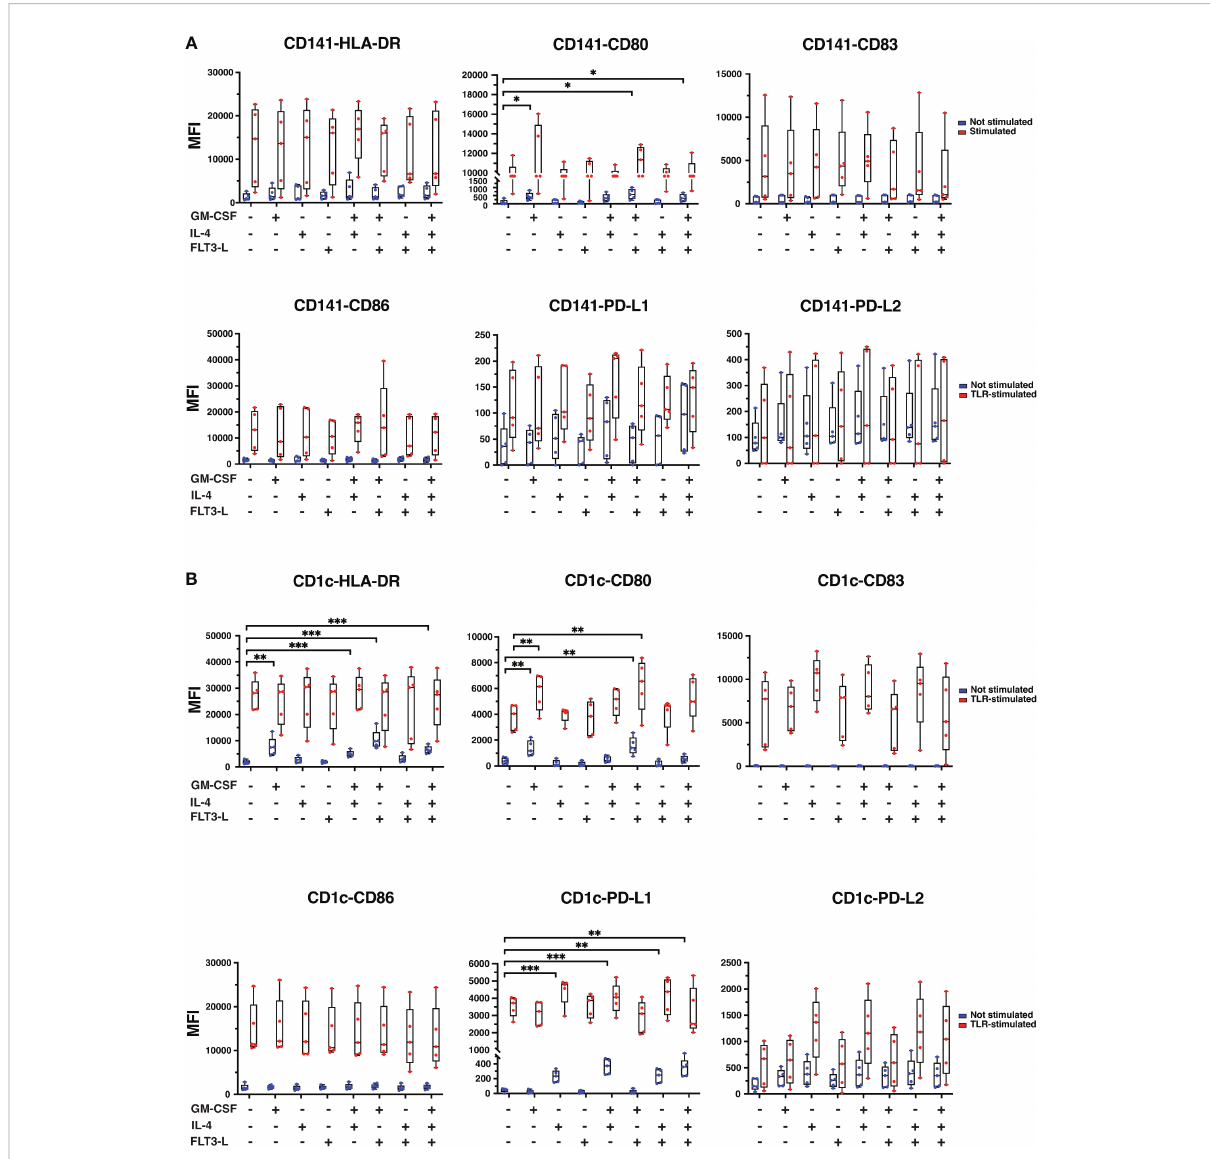
FIGURE 3 The expression of CD surface markers in CD141+ and CD1c+ cells upon different cytokine treatments in the presence or absence of TLR-stimuli for 24hrs. (A) CD141+ and (B) CD1c+ cells were cultured in media containing cytokines as indicated in the graphs. CD141+ cDC was treated with Poly I:C (12.5 µg/ml LMW and 12.5 µg/ml HMW) and CD1c+ cells were treated with 2.5 µg/ml of R848 or remained untreated (Not stimulated) for 24hrs. TLR-stimuli were added at the same time as cytokines. Surface marker expressions were analyzed by fl ow cytometry, and data are presented as mean fl uorescence intensity (MFI). The data represent mean ± standard deviations (SD) of fi ve independent biological replicates. Student ’ s t test analysis was used for calculation of p values ***, p ≤ 0.001; **, p ≤ 0.01; *, p ≤